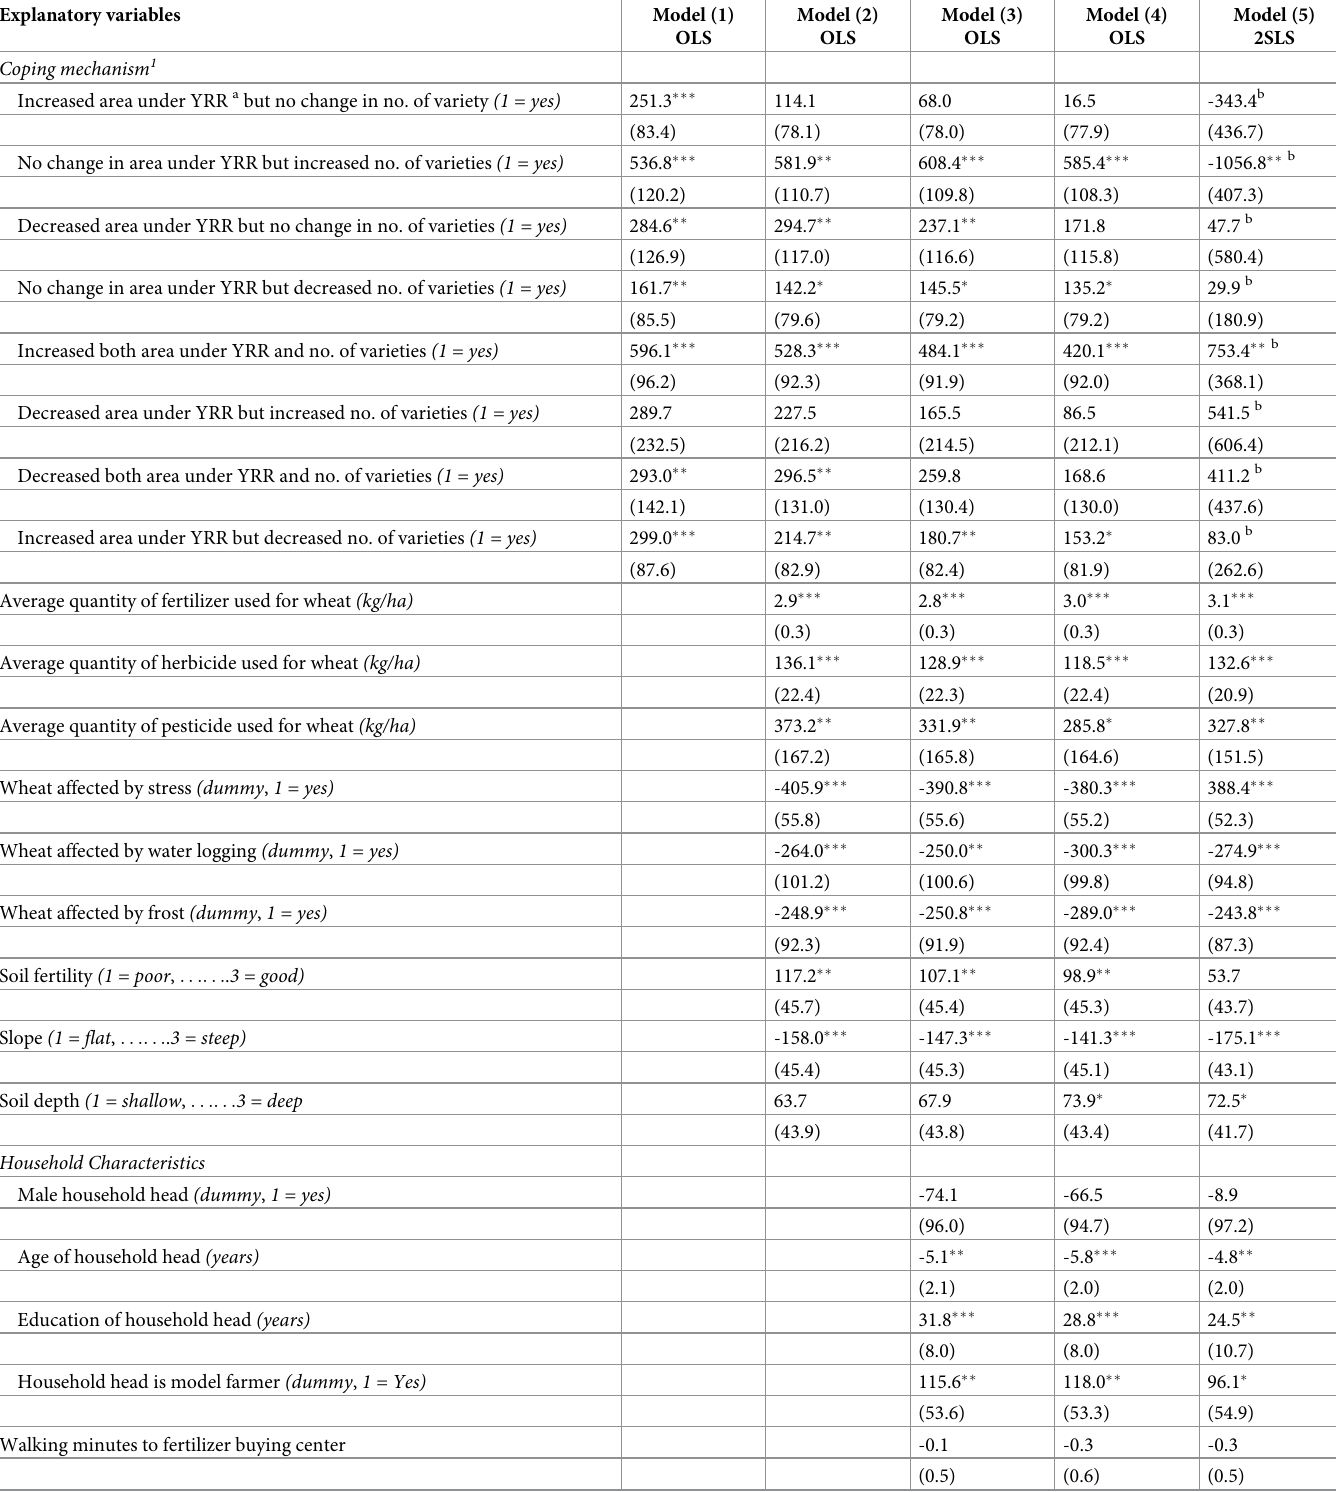
Table 9. Estimated functions explaining wheat grain yield in relation to different wheat rust coping mechanisms and other explanatory factors, Ethiopia (OLS, self- reported wheat yields,